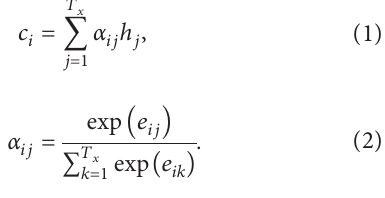
Figure 4: A Tibetan sentence after Wylie